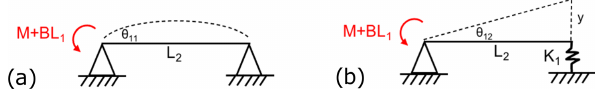
Figure 11. Deflection mechanisms for deflection model 1 under some applied moment M + BL 1 .